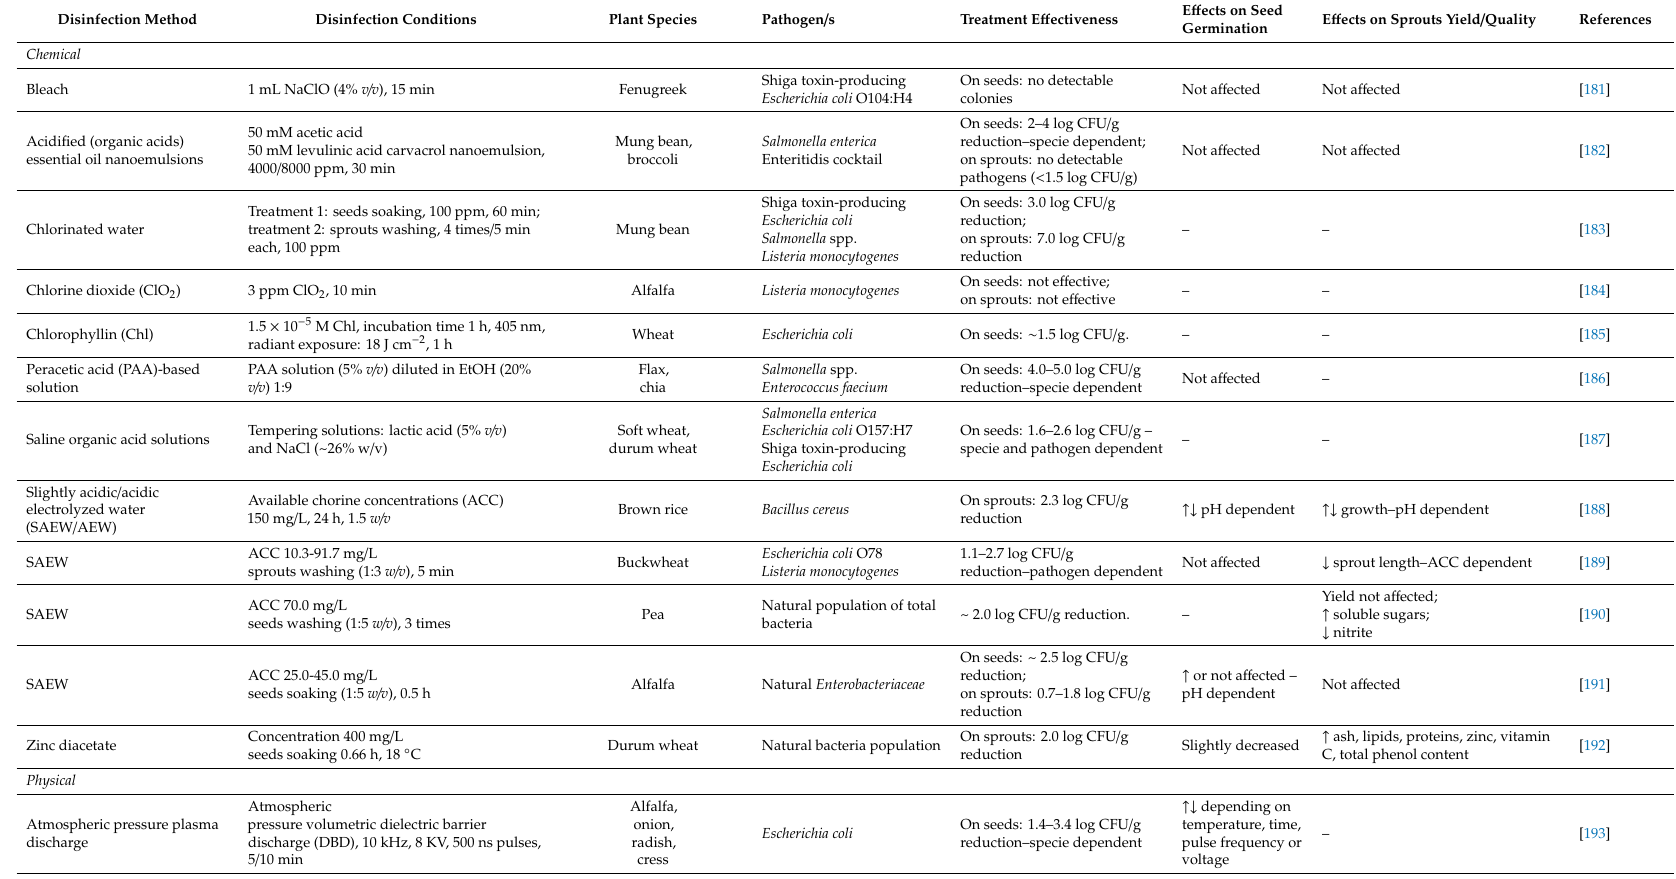
Table 5. Overview of recent studies (dated 2016 onward) about disinfection methods applied to seeds employed for sprout